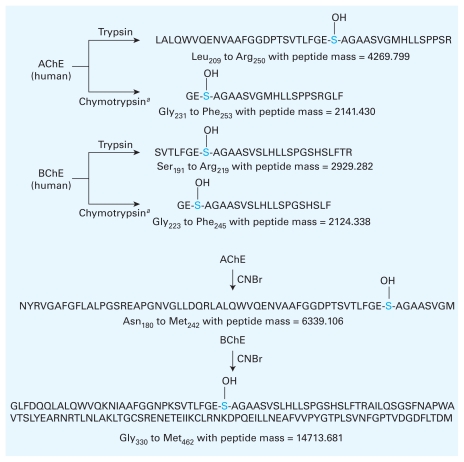
Active site-containing peptides resulting from trypsin, chymotrypsin, and CNBr digests of human AChE and BChE. Cleavages were simulated and masses calculated using ExPASy PeptideCutter (Swiss Institute of Bioinformatics 2007). The active site serine is indicated in blue.aChymotrypsin is high specificity.